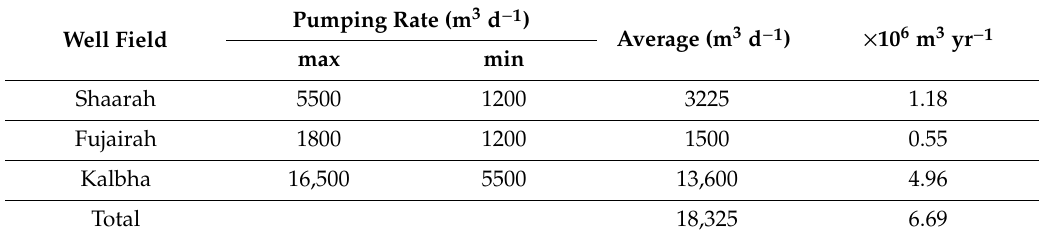
Table 2. Range of Groundwater Pumping from Di ff erent Well Fields